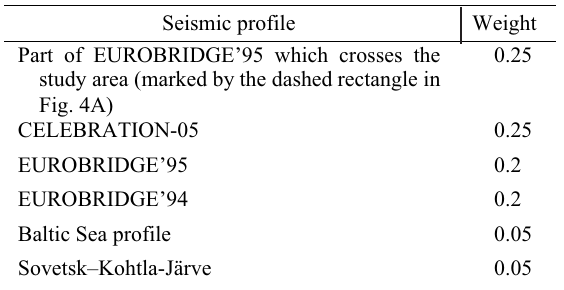
Table 2. Weights assigned to each of the seismic studies in the area